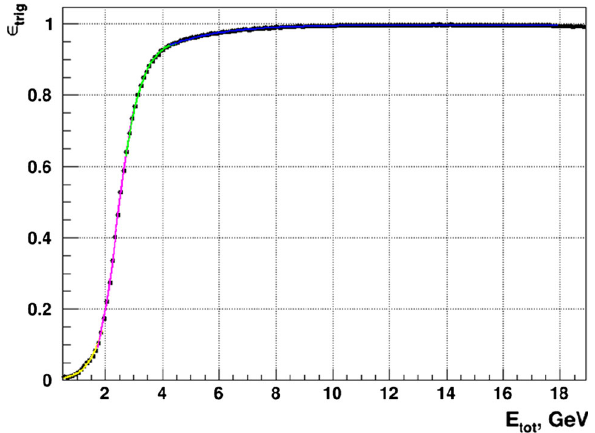
Fig. 3 Triggerefficiency (cid:8) trig asthefunctionoftheGAMStotalenergy deposition. Black points - data, colored curves - fit by the third degree polynomial in four intervals S bk is used for the trigger efficiency measurement (cid:8) trig = ∩ T )/ T ( T GAMS kaon kaon (Fig.